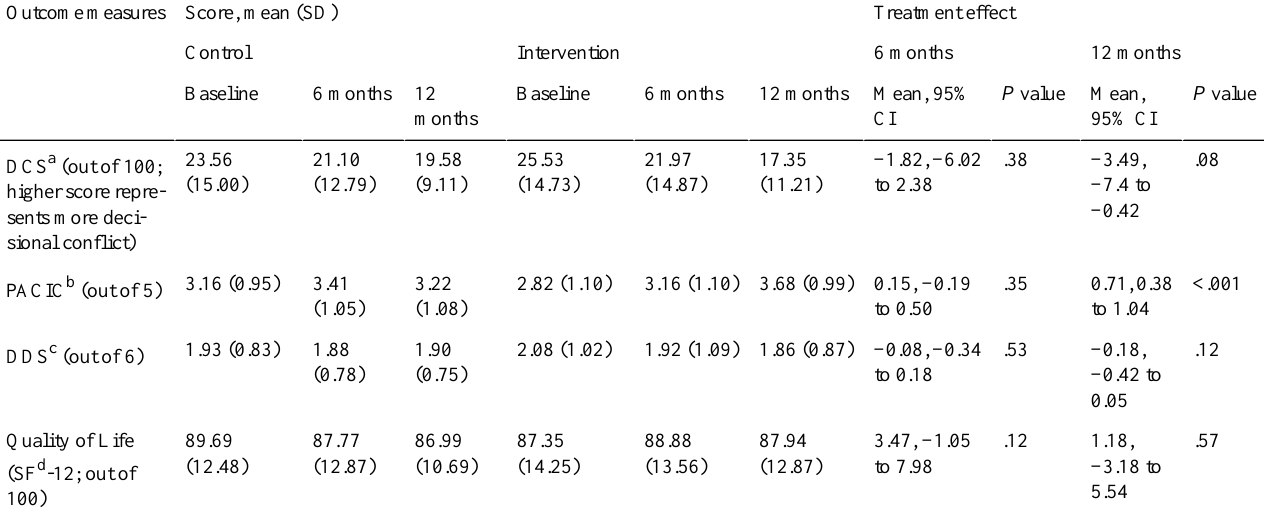
Table 3. Scores at baseline, 6 and 12 months, and treatment effect at 6 and 12 months for decisional conflict, patient assessment of chronic illness care, diabetes distress, and quality of life.